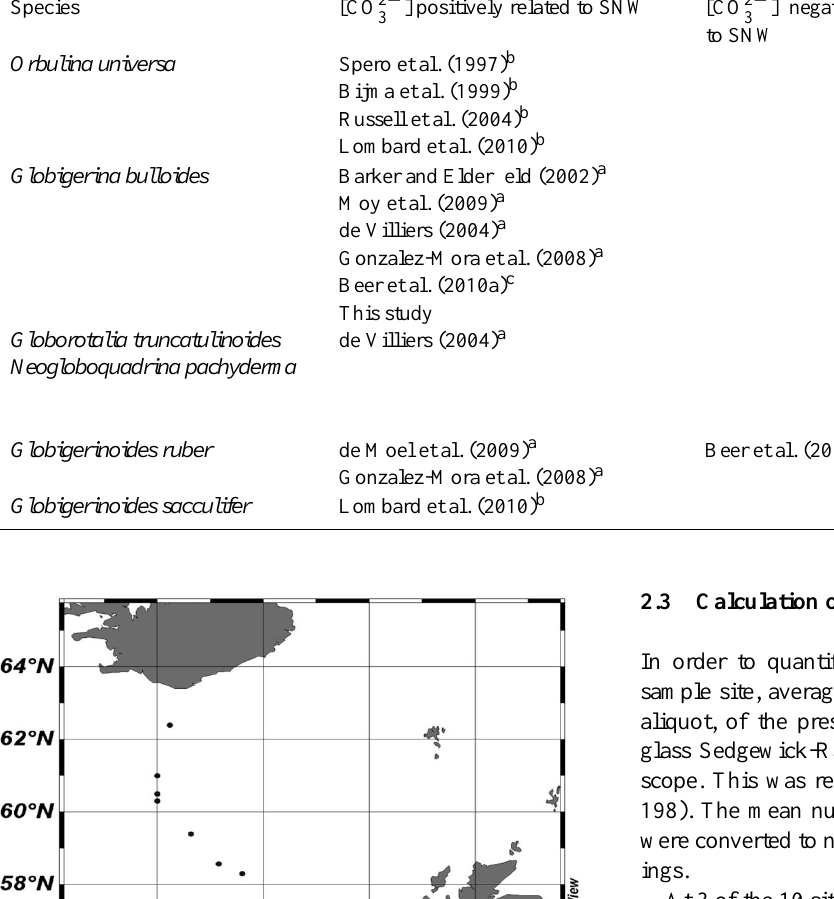
]. Studies that utilized data from: sediment 3